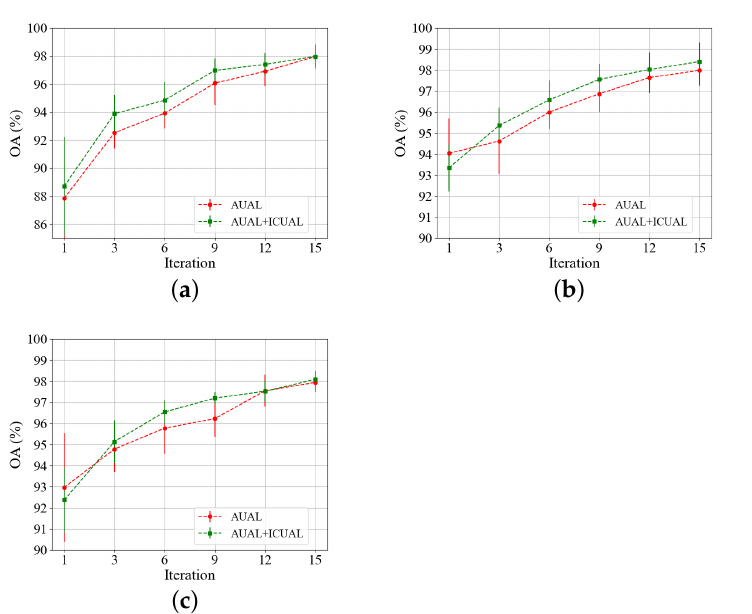
Figure 10. Evolution of OA (%) obtained by AUAL and AUAL+ICUAL as a function of iteration. ( a ) PaviaU, ( b ) Salinas, ( c ) YRD. Table 4. Comparison of AUAL and AUAL + ICUAL after 9 iterations. Data